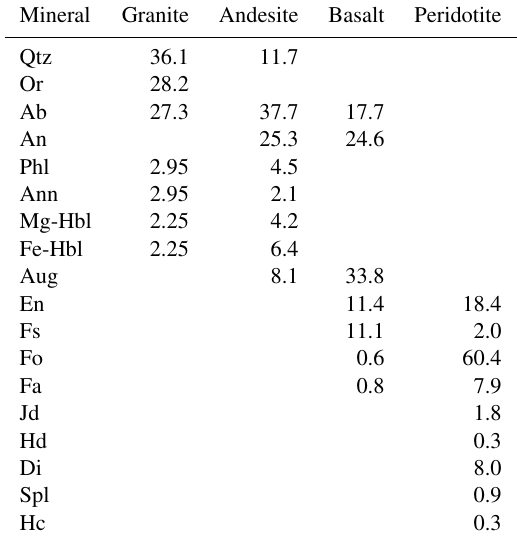
Table A2. Volumetric percentages of the rock-forming minerals within four igneous rocks. Qtz: quartz, Or: orthoclase, Ab: albite, An: anorthite, Phl: phlogopite, Ann: annite, Mg-Hbl: magnesium hornblende, Fe-Hbl: iron hornblende, Aug: augite, En: enstatite, Fs: ferrosilite, Fo: forsterite, Fa: fayalite, Jd: jadeite, Hd: hedenbergite, Di: diopside, Spl: spinel, Hc: